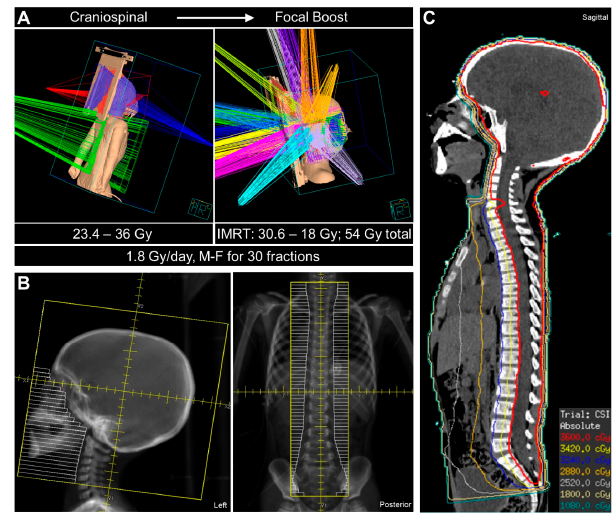
Figure 1. Clinical radiation therapy for medulloblastoma. ( A ) Three-dimensional rendering of craniospinal irradiation (CSI) (left) in a pediatric patient with medulloblastoma treated in the supine position with parallel-opposed lateral beams (red, purple) and a single posterior-to-anterior (PA) beam (green) and with intensity-modulated radiation therapy (IMRT)-based primary tumor site boost irradiation with multiple beams (right). Typical CSI and boost doses and fractionation patterns are noted. M–F, Monday through Friday. ( B ) Beam’s eye view of the cranium (left) and spine (right) CSI fields on digitally reconstructed radiographs (DRRs), with multileaf collimators depicted in white. ( C ) CSI isodose distributions overlaid on the sagittal planning computed tomography (CT)